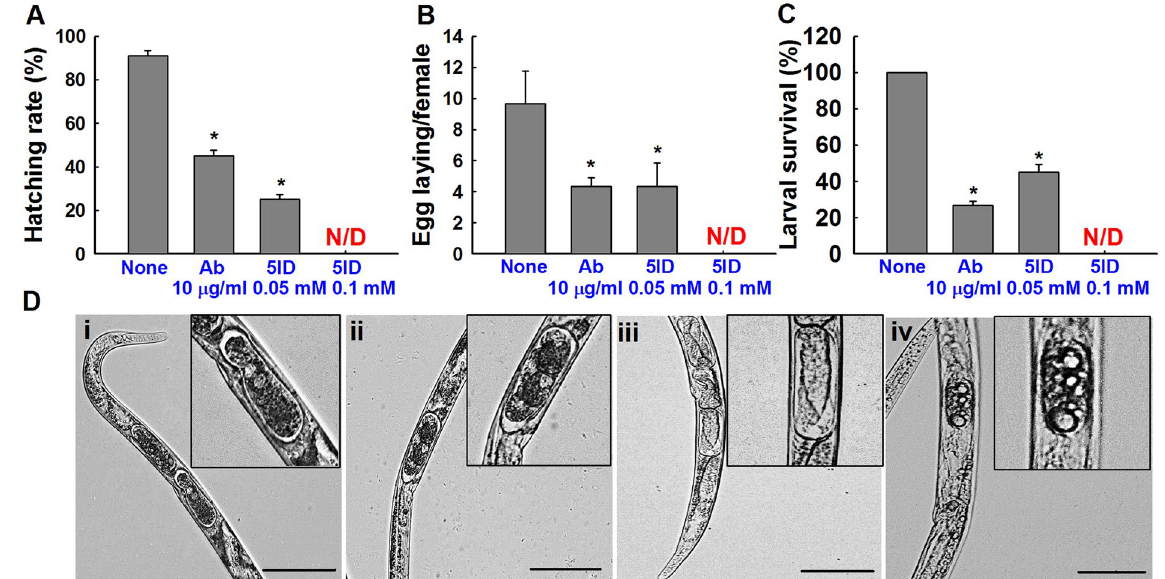
Figure 3. Effects of 5-iodoindole on egg hatching, egg deposition and juvenile mortality. ( A ) Effects of 5-iodoindole and abamectin on cumulative hatching rates after 24 h, ( B ) eggs laid per female nematode after 12 h, ( C ) L2 survival after treatment for 24 h, and ( D ) representative images of female nematodes showing eggs [(i) none, (ii) abamectin (10 µ g/mL), (iii) 5-iodoindole (0.05 mM) and (iv) 5-iodoindole (0.1 mM)]. The graphs (A and C) shows the means ± SEMs of two trials with six repetitions whereas graph B shows the means ± SEMs of three repetitions. * P < 0.05 vs. the non-treated controls; N/D indicates not detected; Scale bars = 50 µ